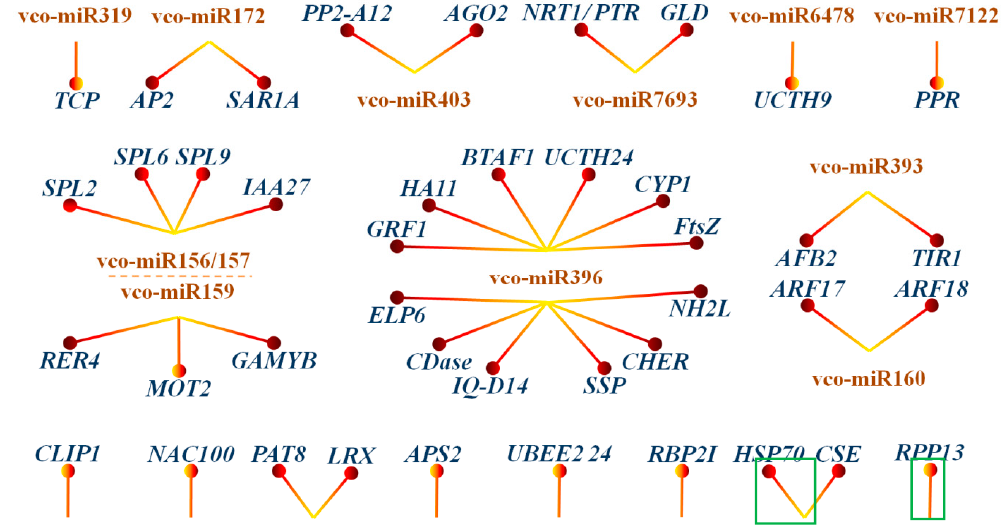
Figure 6. miRNA-mRNA regulatory network involved in blueberry fruit ripening. TCP , TEOSINTE BRANCHED1/CYCLOIDEA/PROLIFERATING CELL NUCLEAR ANTIGEN FACTOR ; AP2 , APETALA 2 ; SAR1A , GTP-BINDING PROTEIN SAR1A-LIKE ; PP2-A12 , PHLOEM PROTEIN 2-A12 ; AGO2 , ARGONAUTE 2 ; NRT1/PTR , NITRATE TRANSPORTER 1/PEPTIDE TRANSPORTER ; GLD , GLUTAREDOXIN-C10 ; UCTH9 , UBIQUITIN CARBOXYL-TERMINAL HYDROLASE 9 ; PPR , PENTATRICOPEPTIDE REPEAT-CONTAINING PROTEIN ; SPL , SQUAMOSA PROMOTER- BINDING-LIKE PROTEIN ; IAA27 , INDOLE-3-ACETIC ACID 27 ; RER4 , RETICULATA-RELATED 4 ; MOT2 , MOLYBDATE TRANSPORTER 2 ; GAMYB , GIBBERELLIC ACID-REGULATED MYB ; GRF1 , GROWTH-REGULATING FACTOR 1 ; HA11 , H(+)-ATPASE 11-LIKE ; BTAF1 , TATA-BINDING PROTEIN-ASSOCIATED FACTOR BTAF1 ; UCTH24 , UBIQUITIN CARBOXYL-TERMINAL HYDROLASE 24 ; CYP , CYCLOPHILIN; FTSZ, FILAMENTING TEMPERATURE SENSITIVE Z ; NH2L , NUDIX HYDROLASE 2-LIKE ; CHER , CALCIUM HOMEOSTASIS ENDOPLASMIC RETICULUM PROTEIN-LIKE ; SSP , SEED STORAGE PROTEIN ; IQD14 , IQ-DOMAIN14 ; CDase , NEUTRAL CERAMIDASE-LIKE ; ELP6 , ELONGATOR COMPLEX PROTEIN 6 ; AFB2 , AUXIN SIGNALING F-BOX 2 ; TIR1 , TRANSPORT INHIBITOR RESPONSE 1 ; ARF , AUXIN RESPONSE FACTOR ; CLIP1 , CAP-GLY DOMAIN-CONTAINING LINKER PROTEIN 1 ; NAC100 , NAC DOMAIN-CONTAINING PROTEIN 100 ; PAT8 , PROTEIN S-ACYLTRANSFERASE 8 ; APS2 , ATP SULFURYLASE ; UBC 24 , UBIQUITIN-CONJUGATING ENZYME E2 24 ; RBP2I , RNA POLYMERASE II SECOND LARGEST SUBUNIT ; HSP70 , HEAT SHOCK 70 kDa PROTEIN 15-LIKE ; RPP13 , DISEASE RESISTANCE RPP13-LIKE PROTEIN 1